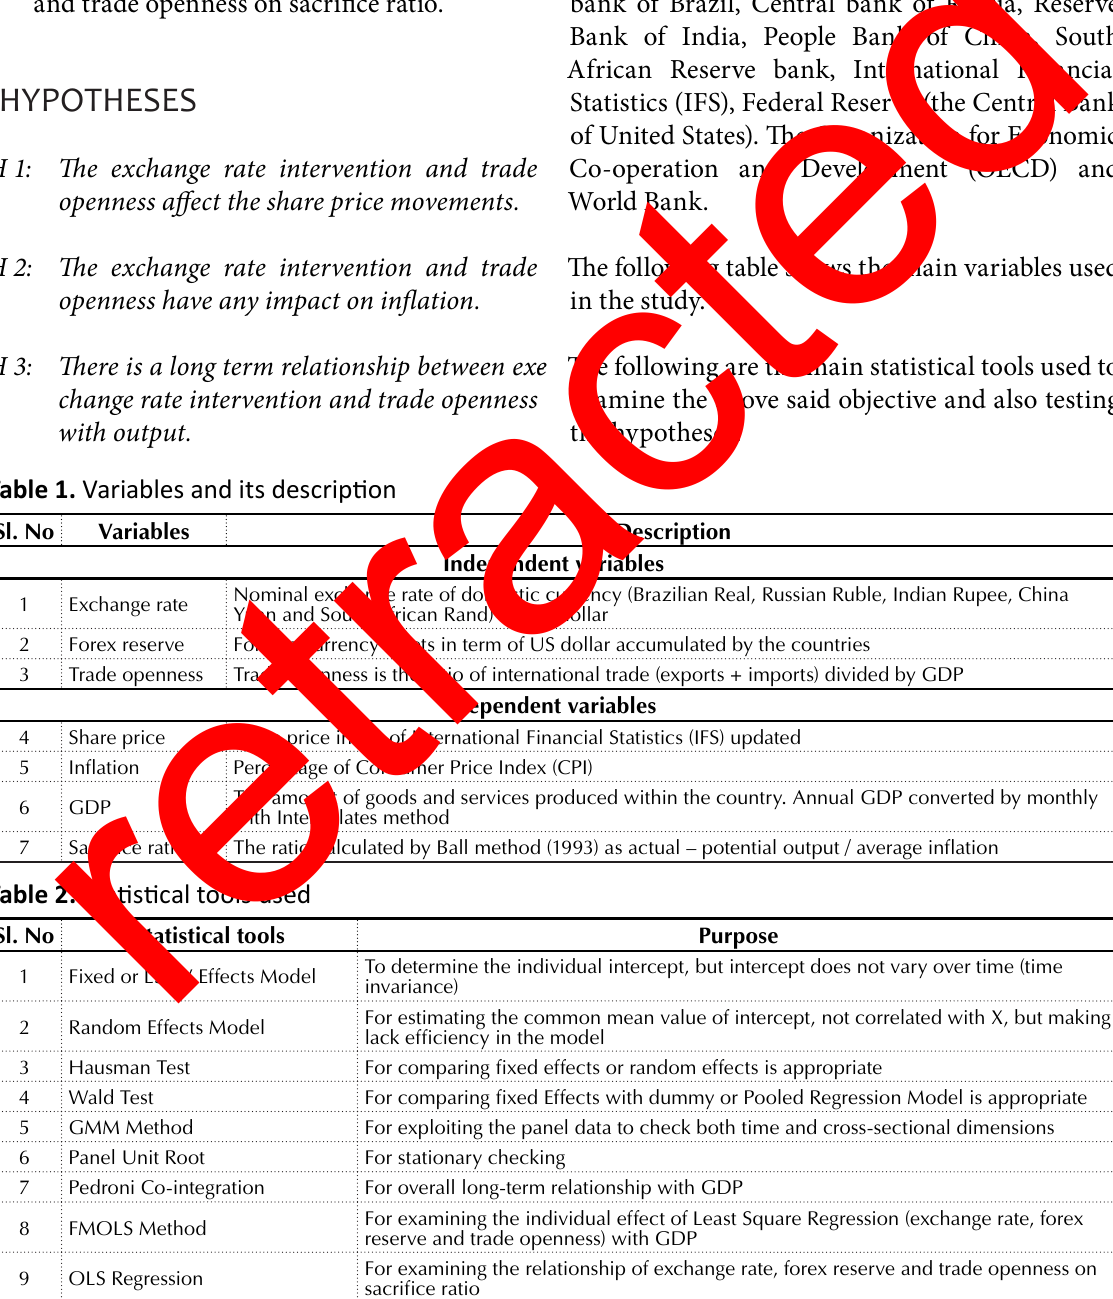
Table 1. Variables and its